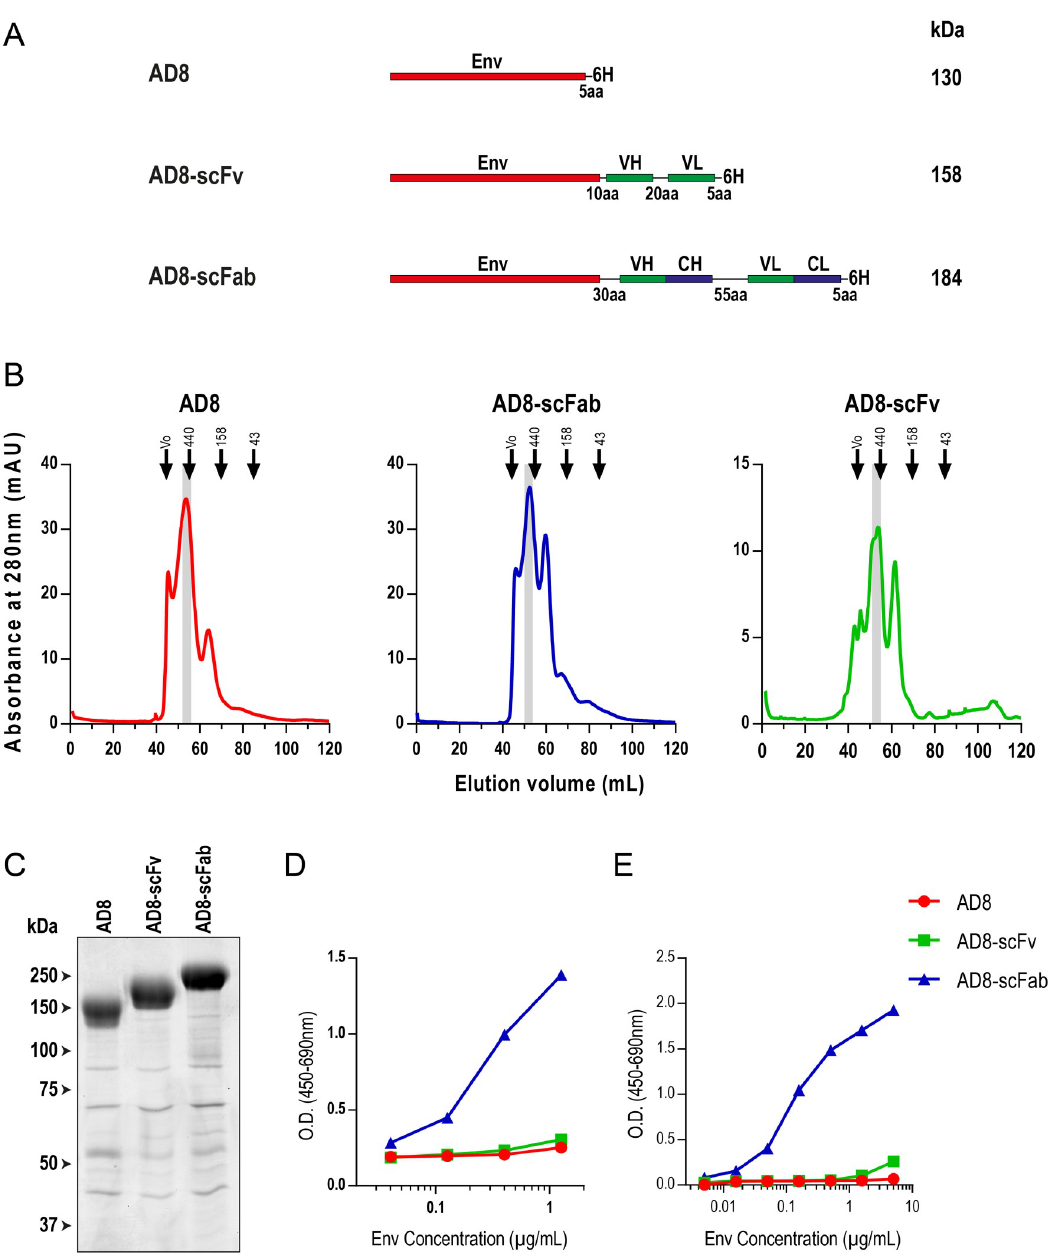
Fig 1. Design and Expression of Clec9A-targeting constructs. (A) Schematic representation of Env constructs with anti-Clec9A scFv and scFab domains. Env is an uncleaved AD8 gp140. The lengths of linkers between domains are given (amino acids = aa). These linkers are composed of serine/glycine repeats n(SGGG). VH = variable heavy, VL = variable light, CH = constant heavy and CL = constant light. A 6X HIS tag is represented by 6H. Approximate molecular weights are given besides each construct, based upon amino acid sequence and predicted occupancy of glycan sites, determined using the NetNGlyc 1.0 Server (Technical University of Denmark). (B) Preparative SEC traces of AD8, AD8-scFv and AD8-scFab. Samples were run on a 16/600 Superdex 200 SEC column and elution was measured using absorbance at 280nm. The void volume (V 0 ) and elution of molecular weight standards are indicated by arrows, and putative trimer-containing peaks, pooled for further use, are shaded grey. (C) Coomassie blue stained purified trimeric proteins following SDS-PAGE. Samples (5 μ g) were run on an 8% SDS-polyacrylamide gel under reducing conditions then stained for total protein with Coomassie Blue R-250. Size standards used were Precision Plus Protein All Blue Standards (Bio-Rad). (D and E) An ELISA was performed to assess binding of Env in tissue culture supernatants prior to purification (D) or purified Env (E) to Clec9A. An ELISA plate was coated with recombinant Clec9A. Env was then added to the first well and diluted in a half log series. The loading of unpurified Env was determined by densitometry analysis of an anti-gp120 western blot, in comparison to purified Env of known concentration. Env binding was detected using pooled HIV+ sera. Due to limitations in the availability of recombinant Clec9A, these results were generated from a single experiment.